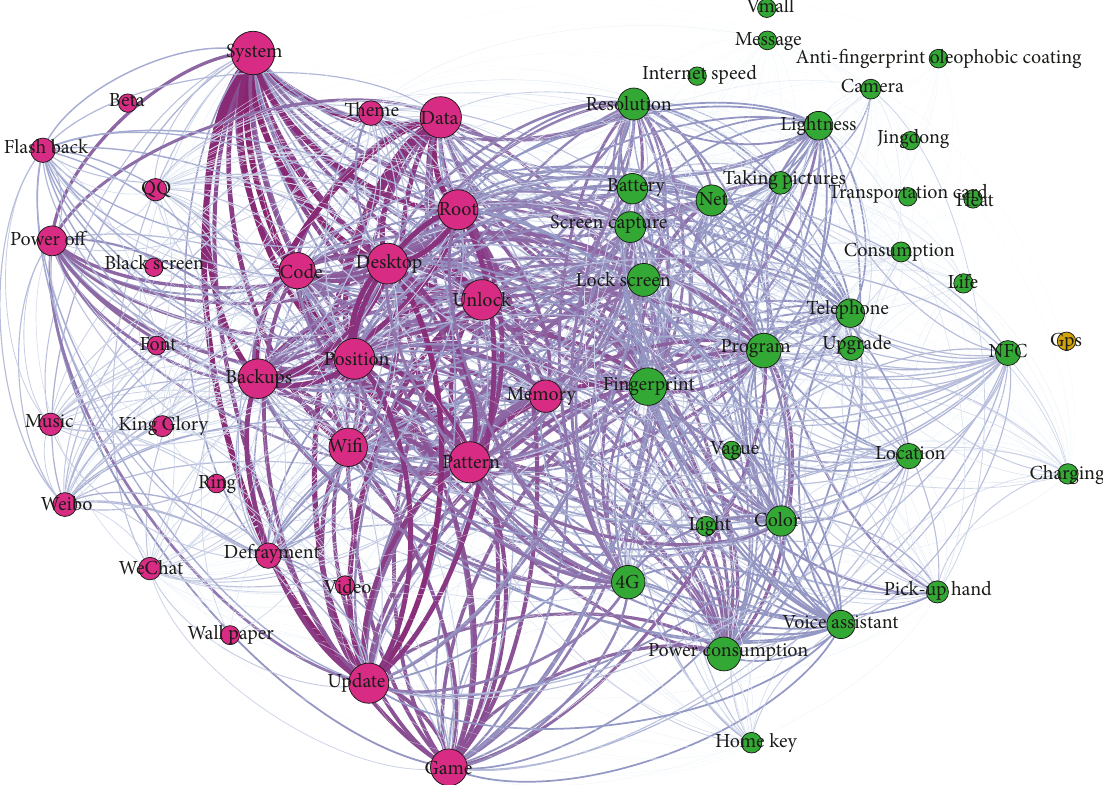
Figure 4: IUG interaction